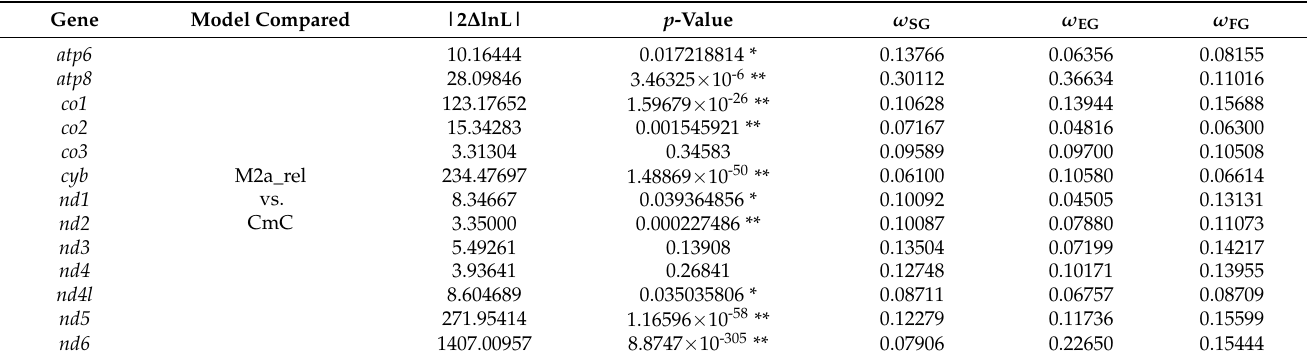
Table 5. Test for positive selection in divergent clades of each mtDNA PCG using Clade model C. Gene Model Compared |2 ∆ lnL| p -Value ω SG ω EG ω FG atp6